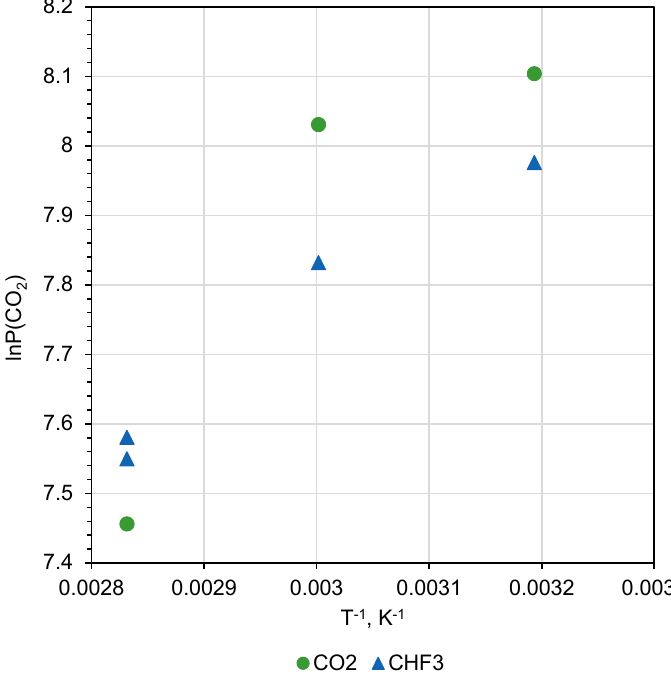
Figure 9. Arrhenius type representation of CO 2 permeability coefficients in dependence on temperature of quaternization reaction in two SCFs.